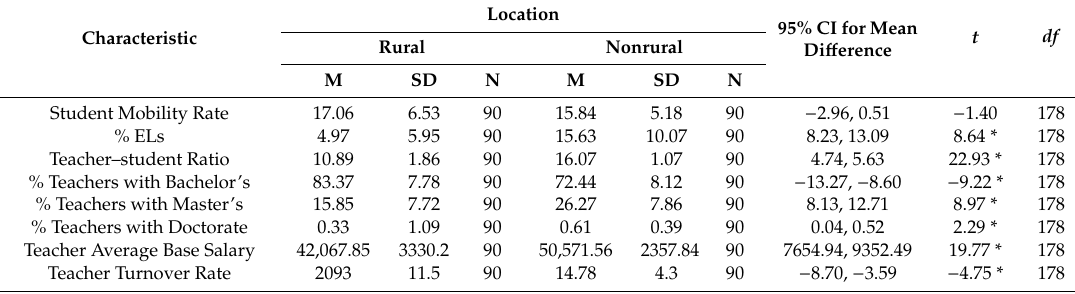
Table 2. T -test results of school district-level characteristics in school year 2011–2012.